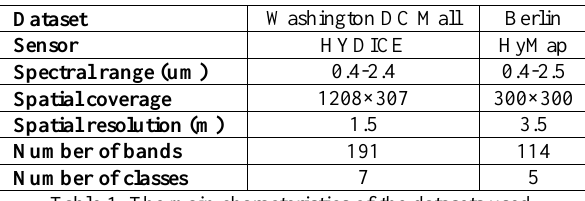
Figure 4. Washington DC Mall image, (a) color composite image, (b) Reference data: shadow, trees, grass, water, road, roofs and trail, (c) Original-MSF classification map, (d) Watershed-MSF classification map, (e) EM-MSF classification map, (f) Hierarchical-MSF classification